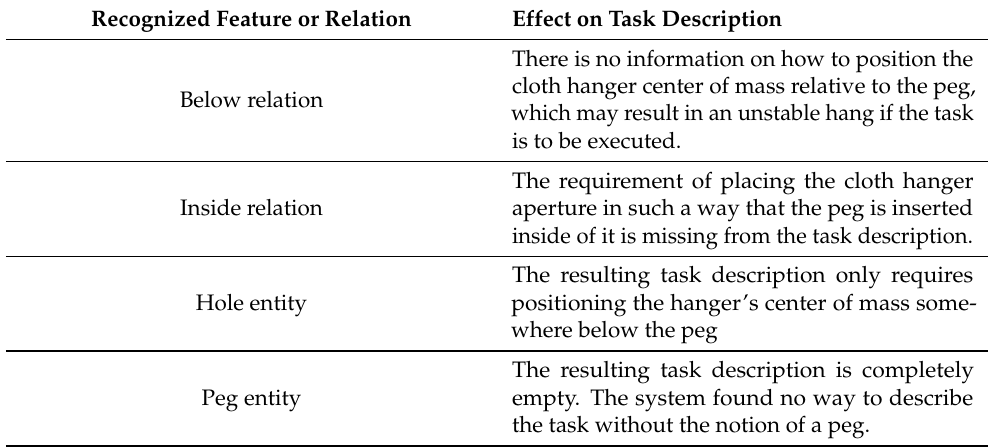
Table 4. The effects of turning off certain recognition routines.